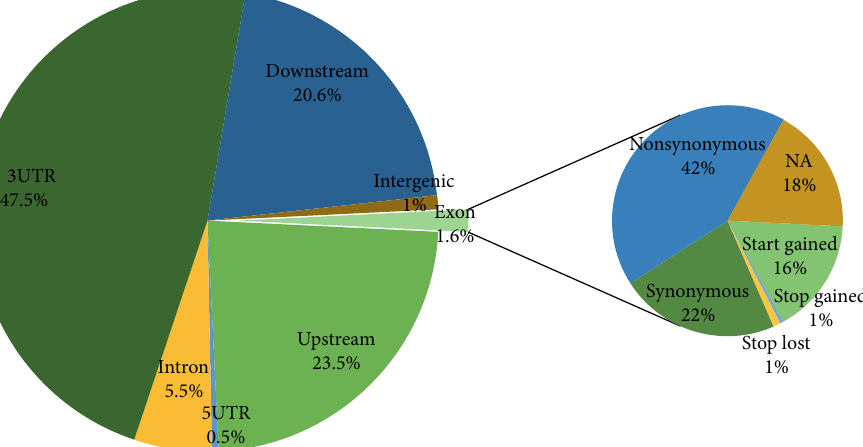
Figure 8: Distribution of RNA editing sites in di ff erent genomic regions.